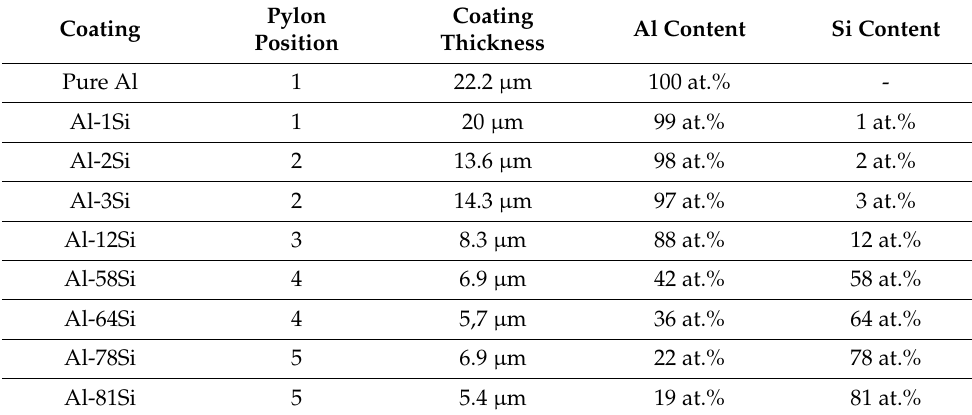
Table 2. The position of the pylons as well as the coating thicknesses and chemical composition (measured by EDS in at.%) of the different Al-Si-based sputtered coatings on a TNB-V2 alloy in the as-coated